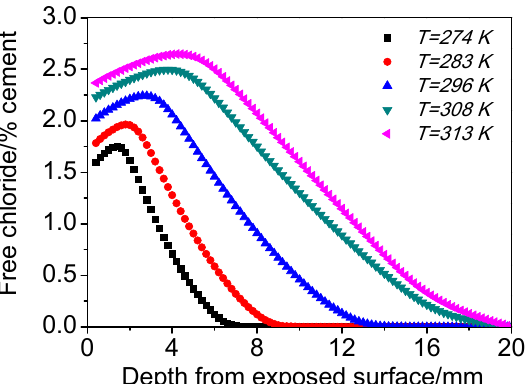
Figure 8. Influence of T on the chloride distribution of concrete subjected to cyclic wetting and drying conditions.